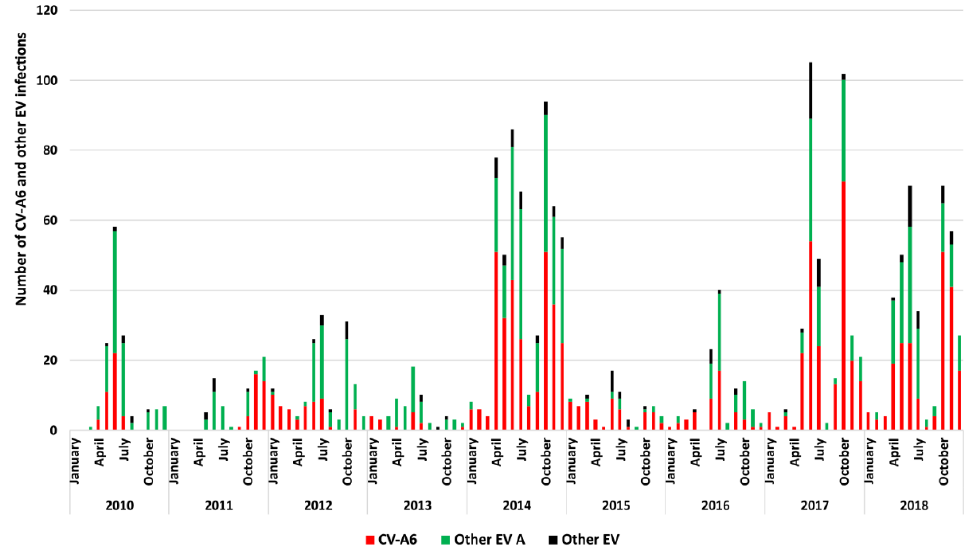
Figure 1. Distribution of CVA6 and other EV types during ambulatory hand-foot-and-mouth disease surveillance. From April 2010 to March 2014, the data are from the surveillance of the population of the Clermont-Ferrand city area. From April 2015 to April 2017, the comprehensive national surveillance was interrupted. Colour code: red, CVA6; green, EV-A other than CVA6; black, other EV types. Table 1. Demographic and clinical data of patients with hand-foot-and-mouth disease/herpangina and genotyping test positive for coxsackievirus A6.